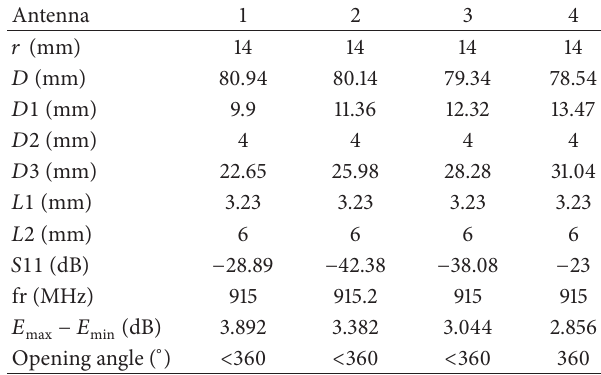
Table 8: Dimensions of each 3D spherical antenna (Figure 18) with the simulation